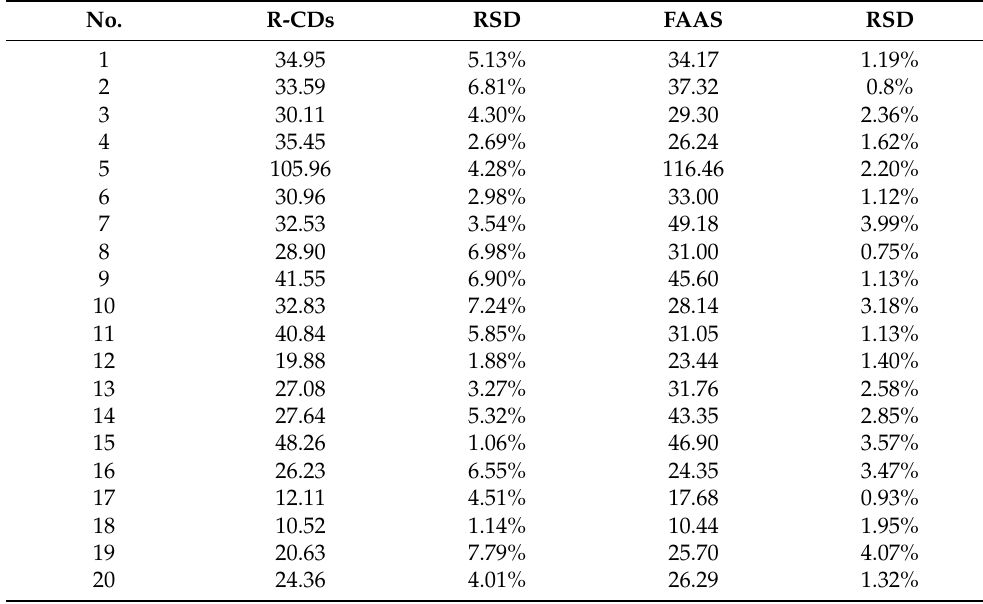
Table 3. Comparison of Mn 2+ content in samples detected by two methods.